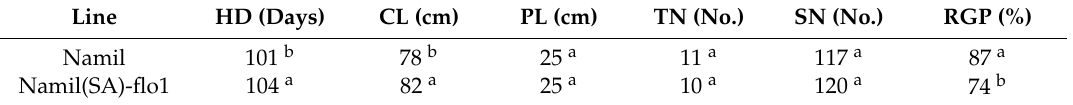
Table 1. Major agronomic traits of Namil(SA)-flo1 in comparison with its wild type,